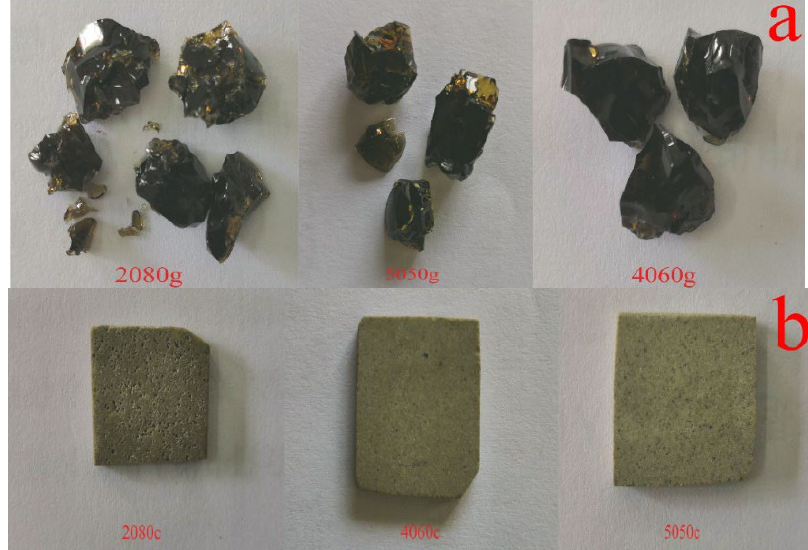
Figure 2. Photographs of glass ( a ) and glass ceramic ( b ) samples.